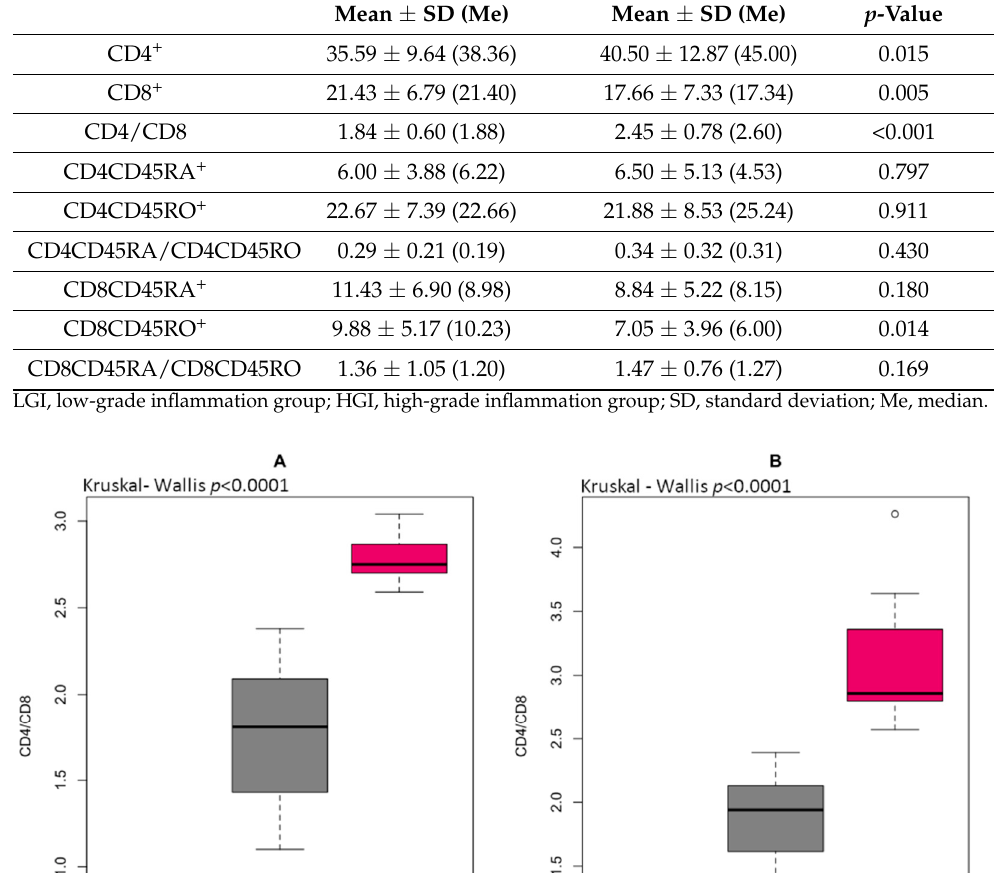
Table 7. Distribution of T lymphocytes. Table 8. The statistical characteristics of the ROC curve for the univariate logistic model for T lymphocyte distribution.